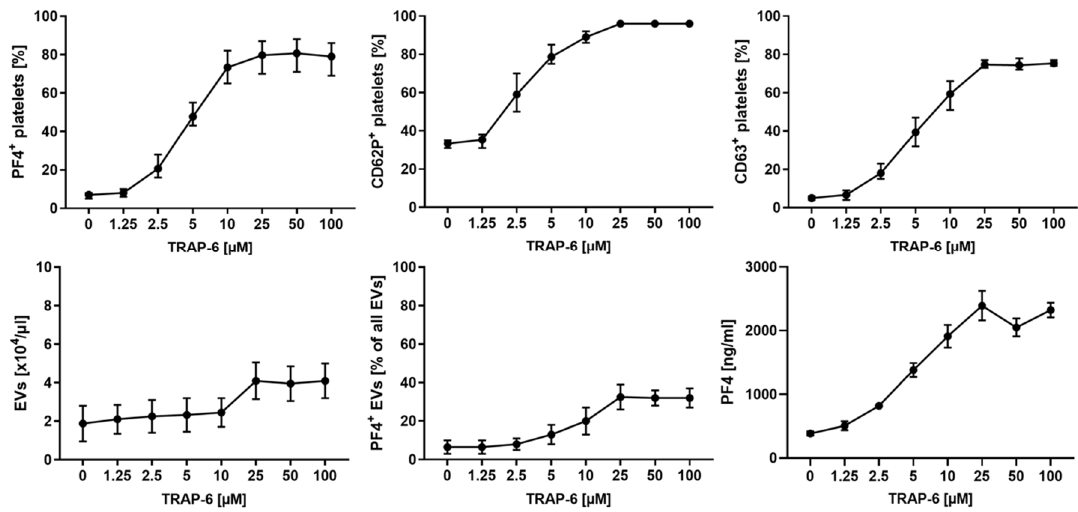
Figure 2. Platelet activation with TRAP-6. Platelets suspended in SSP + anticoagulated with ACD-A 1:12 (233 ± 41 × 10 3 platelets/ µ L) were activated for 10 min at room temperature with 1.25, 2.5, 5, 10, 25, 50